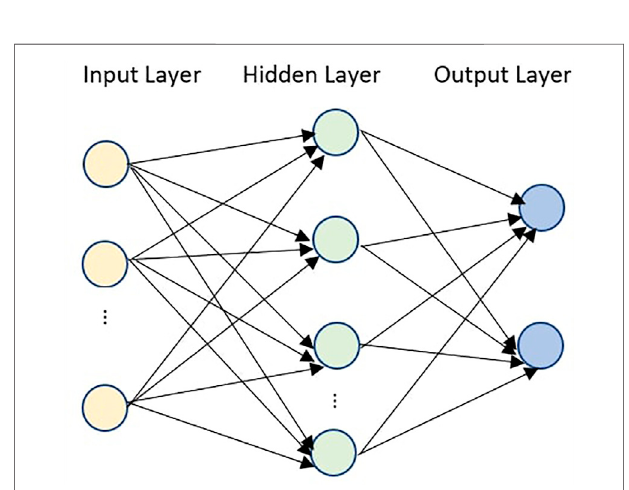
FIGURE 3 | 3 layer ANN with a single input, hidden and output